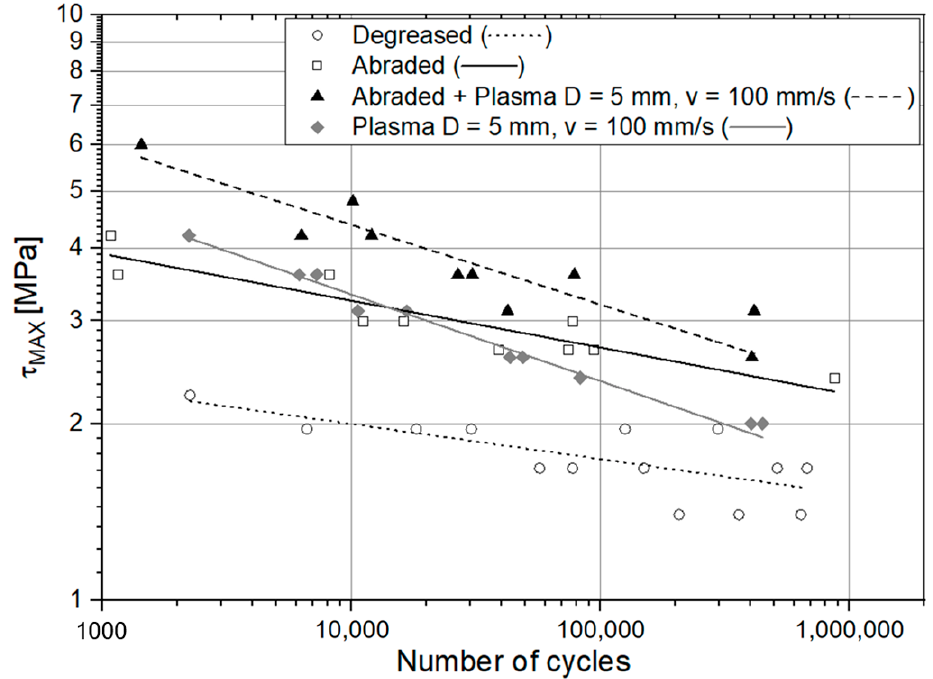
Figure 17. S-N curves for the following set of specimens: degreased, abraded, abraded + APPT (D = 5 mm and v = 100 mm/s) and APPT with D = 5 mm and v = 100 mm/s (the lines represent the power-law trend curves).